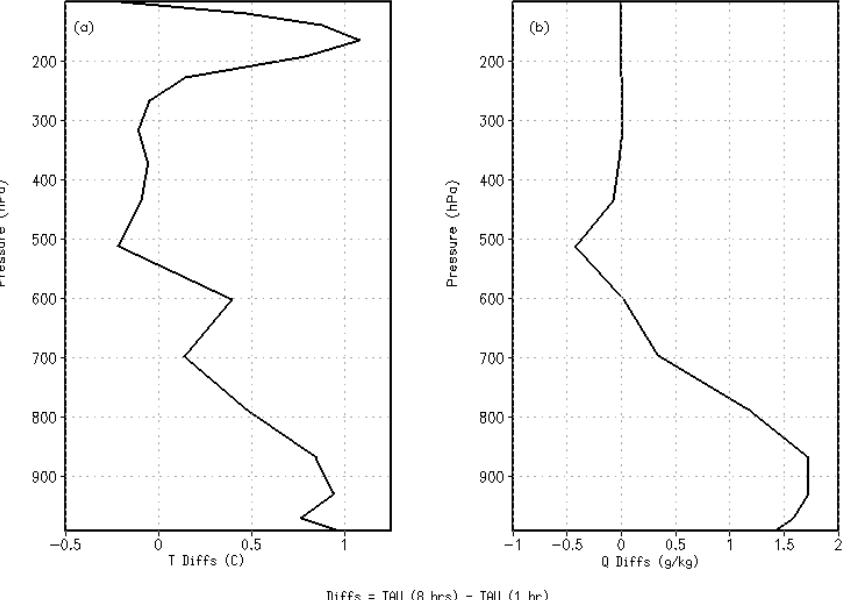
Fig. 8. Vertical structure of the time mean area averaged quantities over 0 ◦ E to 360 ◦ E and 7 ◦ S to 7 ◦ N with TAU (1h) and TAU (8h). (a) T , and (b) Q